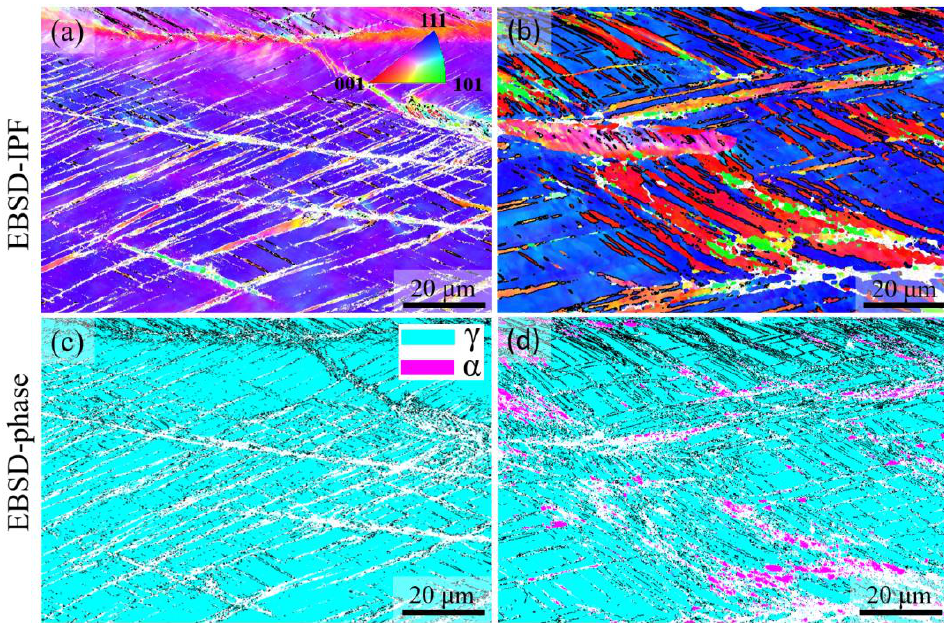
Figure 11. EBSD results for ( a , c ) 0Al and ( b , d ) 3Al steels after tensile deformation until fracture at room temperature. ( a , b ) IPF maps, ( c , d ) phase maps. Colors in IPF maps indicate crystal directions parallel to the tensile direction. In ( a , b ), boundaries within ±5° from the Σ3 twin relationship are superimposed using black lines.